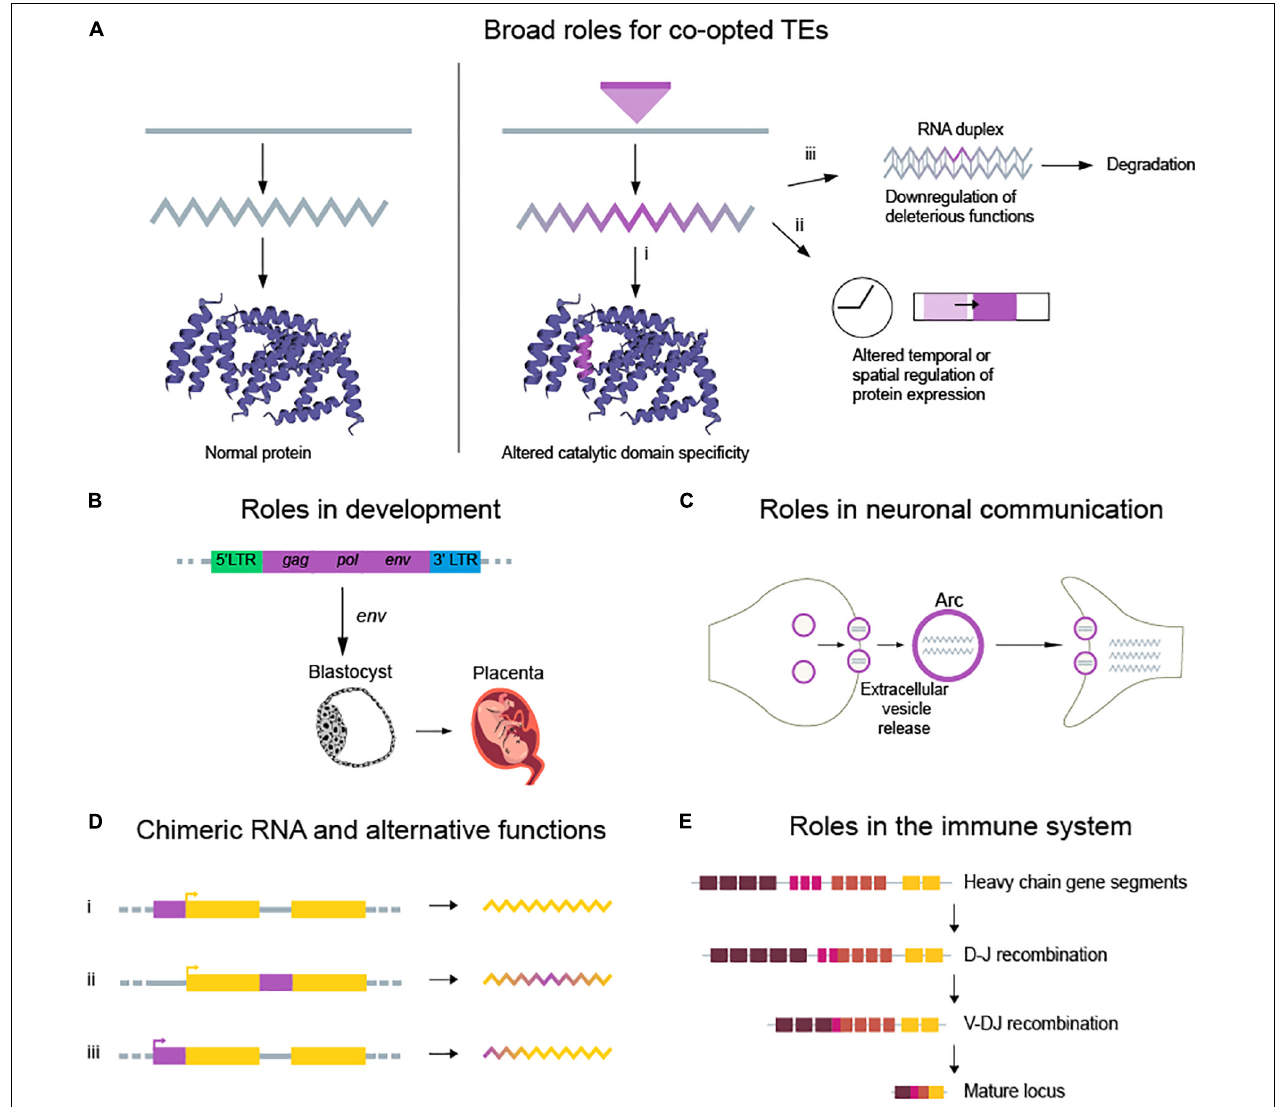
FIGURE 2 | Examples of beneficial TE functions that arose through co-option. (A) Beneficial TE functions can be broadly classified into three categories: introducing new gene functions, regulating existing functions, or downregulating negative functions. (i) New gene functions are typically introduced through co-option of TEs, repurposing natural cut/paste or copy/paste activities, which can result in new beneficial functions. (ii) Altered spatiotemporal gene expression occurs through insertion or modification of cis -regulatory elements, which can introduce binding sites for transcription and regulatory factors. (iii) Downregulation of deleterious genes can be achieved at transcriptional and post-transcriptional levels through small RNA hybridization and degradation of specific targets. (B) Upregulation of ERVs during embryonic development provides cis and trans elements for the expression of genes involved in pluripotency. (C) The Arc protein, derived from the gag protein of retrotransposons, forms capsid-like structures that deliver mRNA during neuronal communication. (D) TEs regulate the expression of neighboring genes in various ways (i) by acting as enhancers, (ii) by modulating splicing junctions, and (iii) by functioning as promoters. (E) RAG1 and RAG2 , thought to be derived from TEs, mediate V(D)J recombination. This process generates the diverse repertoire of antigen receptors in immune